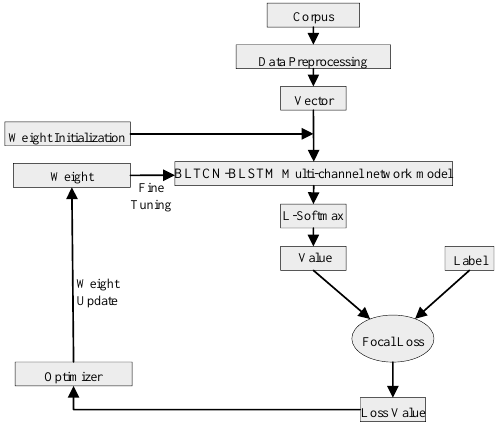
Figure 1. Multi-channel BLTCN-BLSTM self-attention model process. Figure 1. Multi‑channel BLTCN‑BLSTM self‑attention model